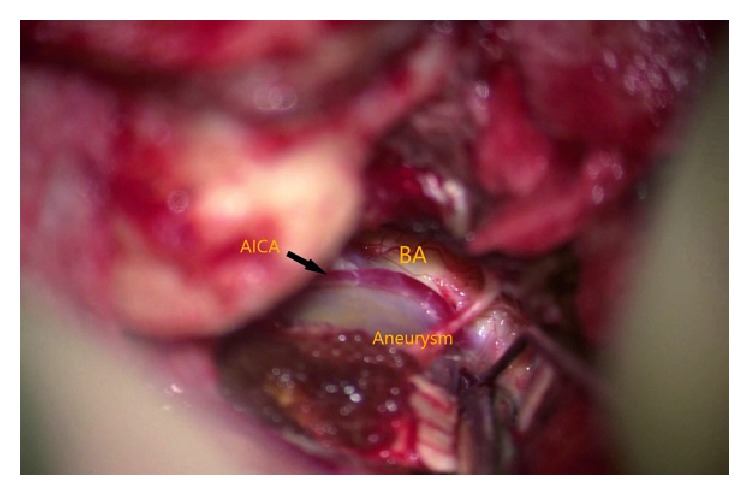
Aneurysm exposure.